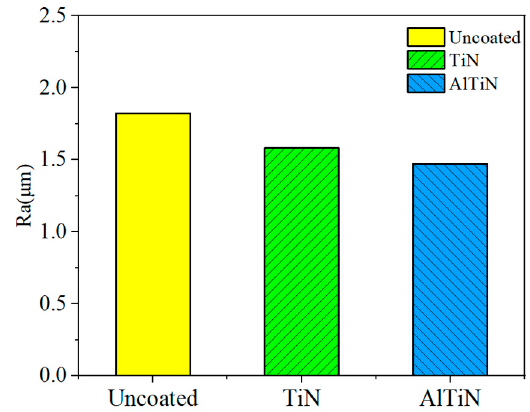
Figure 10. Ra of machined surface.